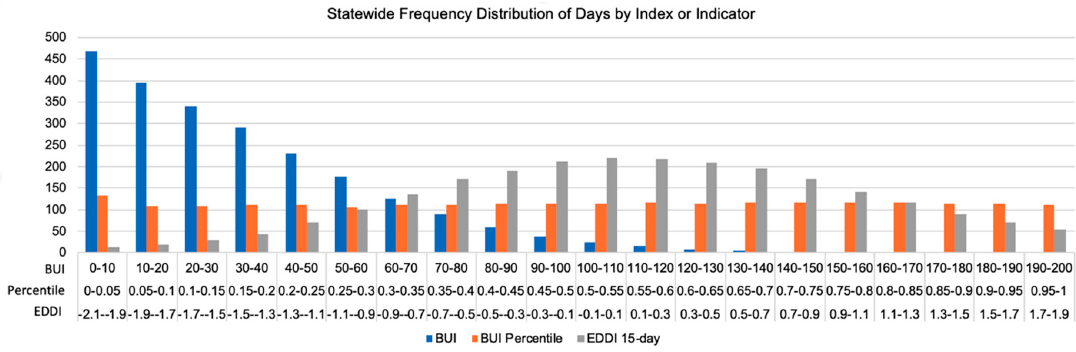
Figure 11. All-Days frequency distribution by range for an objective index (BUI in blue), percentile rank (BUI Percentile in orange), and a normalized index (EDDI 15-day in gray).